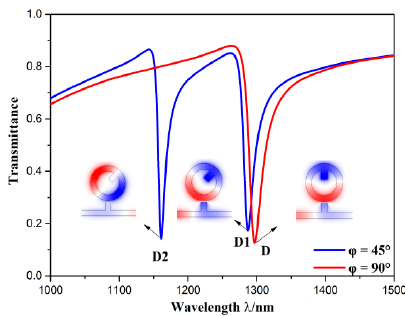
Figure 4. Transmission spectra of the 45° structure and 90° structure. The normalized H Z field distributions at their dips are depicted in the inset.